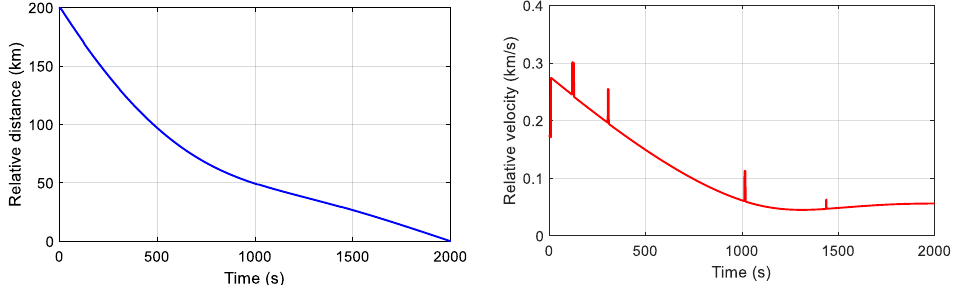
Figure 11. The pursuit success percentage per 100 episodes during the training.